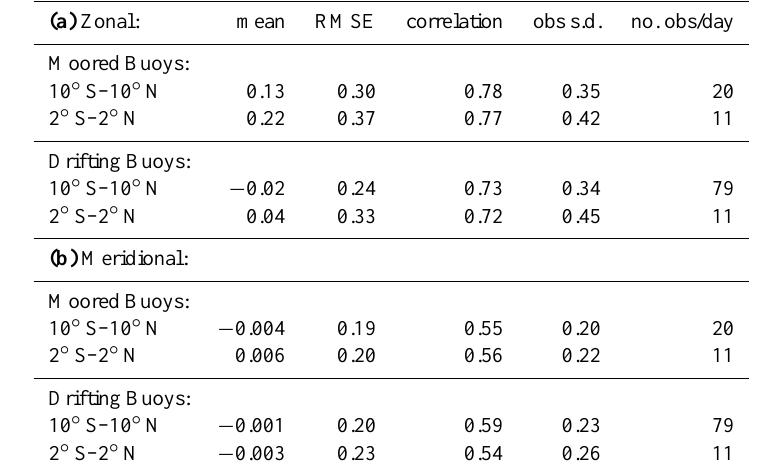
Table 1. Comparison of summary statistics for FOAM V1 velocity analyses against the global tropical moored buoy array (top half) and the drifter-derived currents (bottom half) for the whole of the global equatorial ocean. Statistics for zonal velocity are in Table 1a and for meridional velocity in Table 1b. Summary measures shown are mean error (observation-model), root-mean-square error (RMSE), Pearson correlation and the standard deviation of the observations. Also included are the average numbers of observations per day. Results are shown separately for two regions defined as being within 10 ◦ and 2 ◦ of the Equator